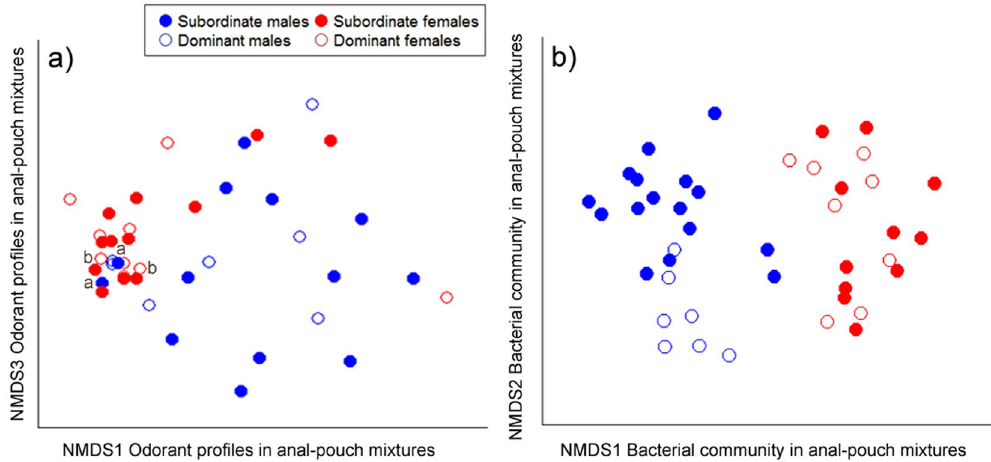
Figure 2. NMDS plots based on Bray-Curtis distances in ( a ) the chemical composition and ( b ) the bacterial community of anal-pouch mixtures, showing separation between meerkats by their sex and social class (2D stress of 0.12 and 0.18, for chemical composition and bacterial community, respectively). In ( a ), the two meerkats that were sampled twice are denoted by the letters a and b, referring to the nearest two solid blue and two open red symbols,